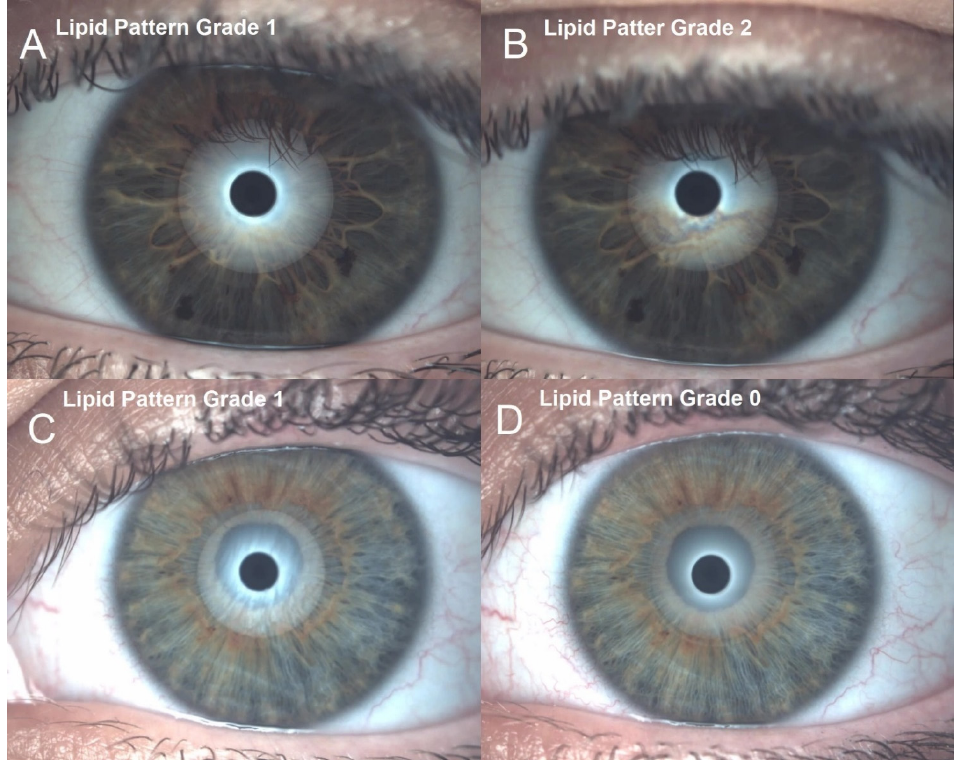
Figure 2. Interferometric lipid pattern differences between previous eye drop instillation (left) and 45 min after instillation (right). ( A , B ) CHA group before and after eyedrop. ( C , D ) HA group before and after eyedrop.